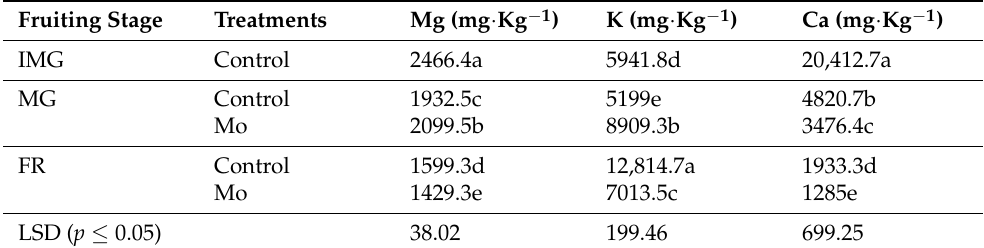
Table 8. Effect of foliar application of molybdenum on macronutrient concentrations in fruit pulp of